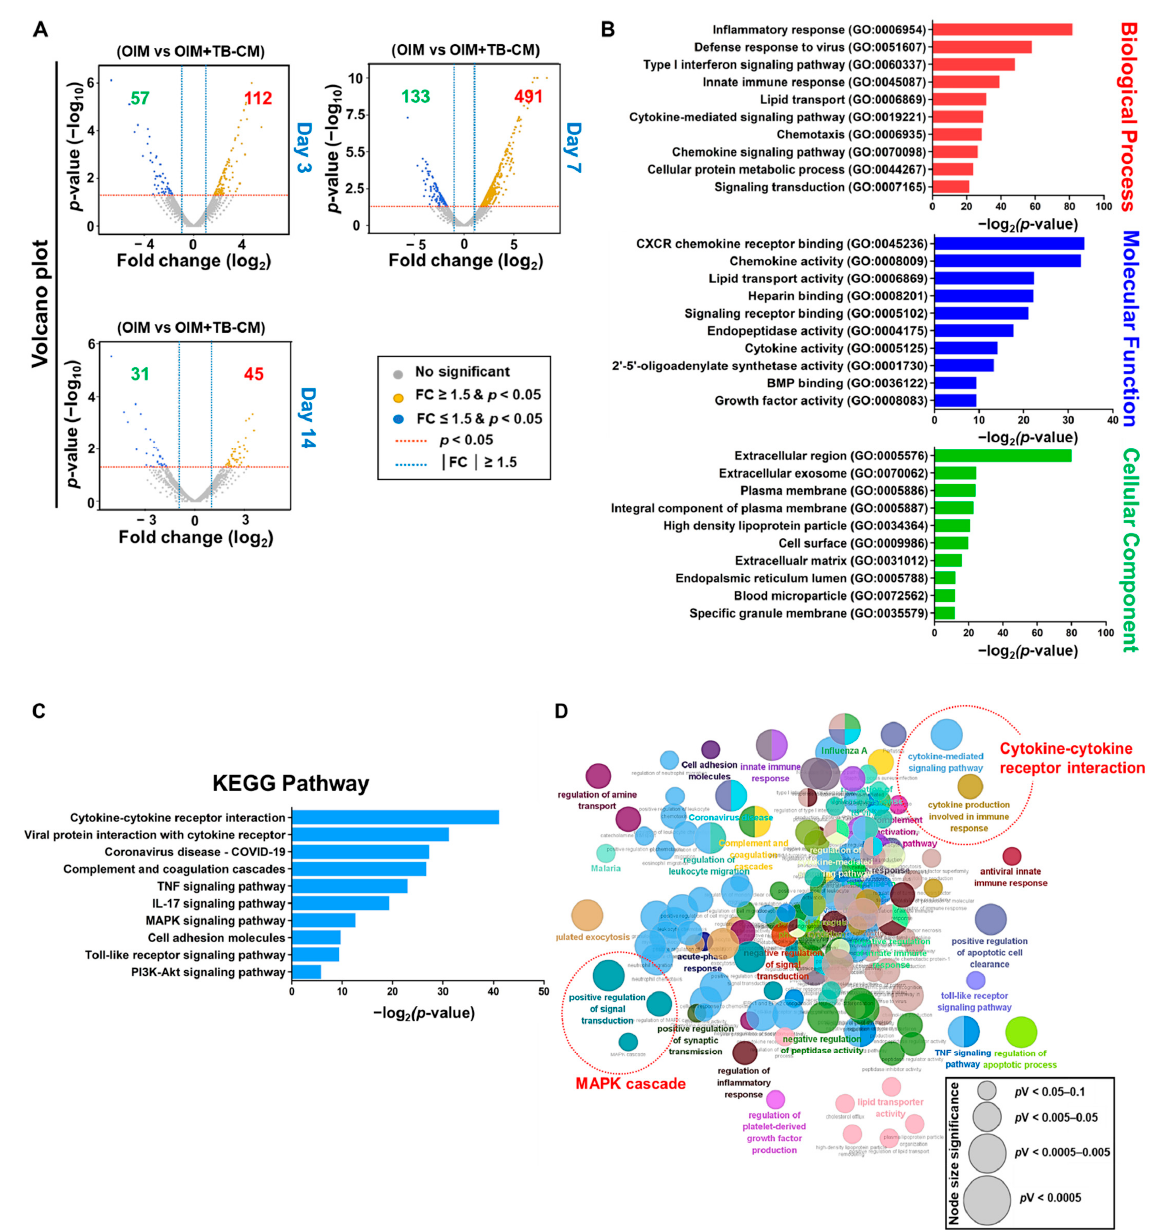
Figure 4. Enrichment analysis of GO terms and KEGG pathways in the TB-CM-treated mesenchymal stem cells (MSCs) during osteogenesis. MSCs were treated with 30% TB-CM under OIM conditions. RNA-seq was performed to identify the differentially expressed genes (DEGs) in the treated MSCs. ( A ) The significantly upregulated and downregulated DEGs are represented in the form of a volcano plot ( p < 0.05, FC ≥ 1.5). ( B ) DEGs were assigned to three GO categories: biological processes (red bars), molecular functions (blue bars), and cellular components (green bars). The enrichment scores of the GO terms are shown as − log 10 ( p -value). ( C ) The ten most significant pathways of DEGs in TB-CM-treated MSCs are presented using a bar chart with enrichment scores shown as { − log 10 ( p -value)}. ( D ) Biological processes and pathways of DEGs in the TB-CM-treated MSCs were analyzed using the ClueGO bioinformatics tool. The most significant GO terms and pathways per functional group are shown in bold and in the same color. Node size depicts the level of statistical significance ( p < 0.05). Consistently analyzed terms, including cytokine-mediated signaling pathways and MAPK cascades, are indicated by red circles. TB-CM, trophoblast-derived conditioned medium; GO, gene ontology; KEGG, Kyoto Encyclopedia of Genes and Genomes; MAPK, mitogen-activated protein